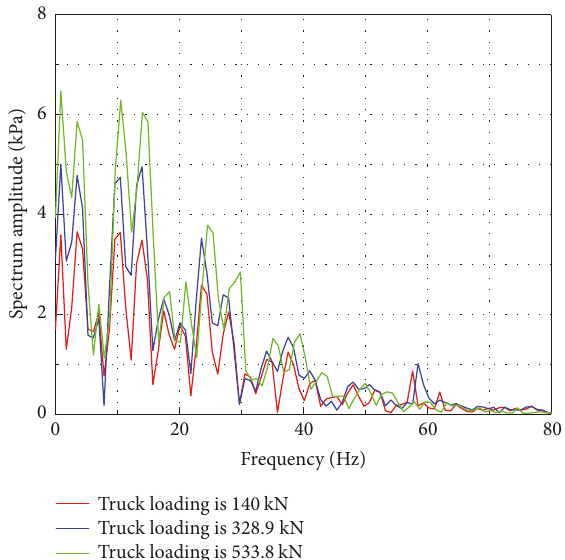
Figure 8: Spectrum curves of dynamic pressure on the top of the base course under different truck